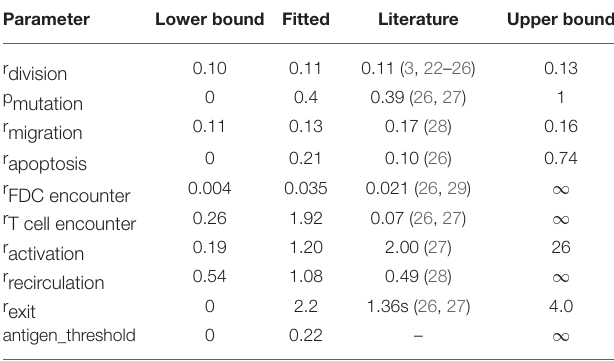
TABLE 1 | Parameter values and ranges of